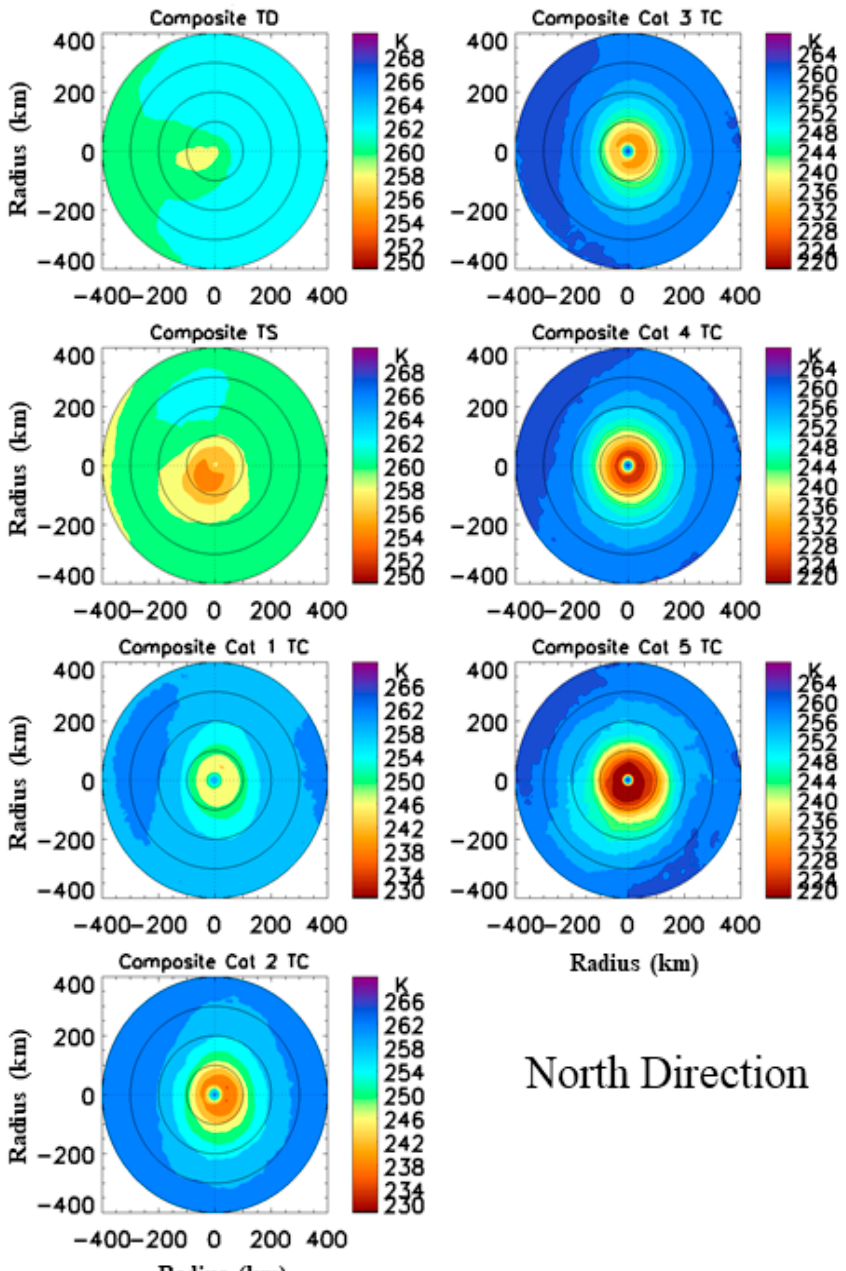
Figure 4. Climatology of the composited global TC structure relative to the North direction at each storm intensity category from PMW sensors at 89H GHz in 1987–2012.